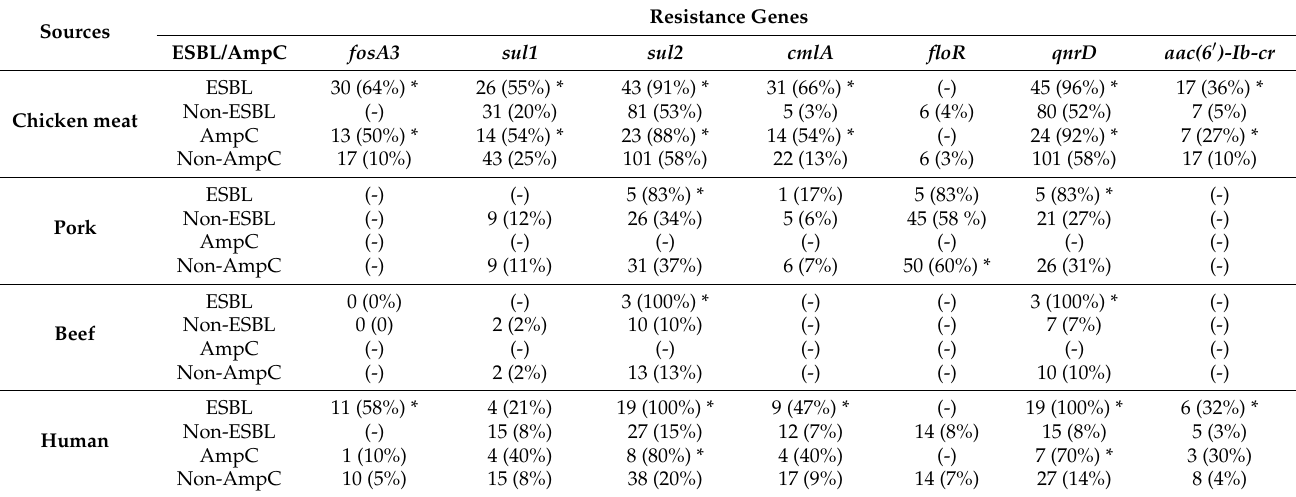
Table 2. Distribution of non- β -lactam antimicrobial resistance genes in ESBL/AmpC-producing and non-ESBL/AmpC-producing P. mirabilis strains isolated from chicken, beef, pork and